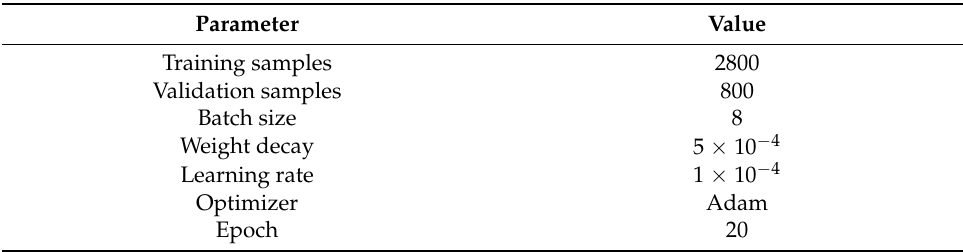
Figure 6. Indicator change line chart. ( a ) Line chart of accuracy value changes of 20 epochs. ( b ) line chart of loss value changes of 20 epochs. Table 1. Training parameters of model.